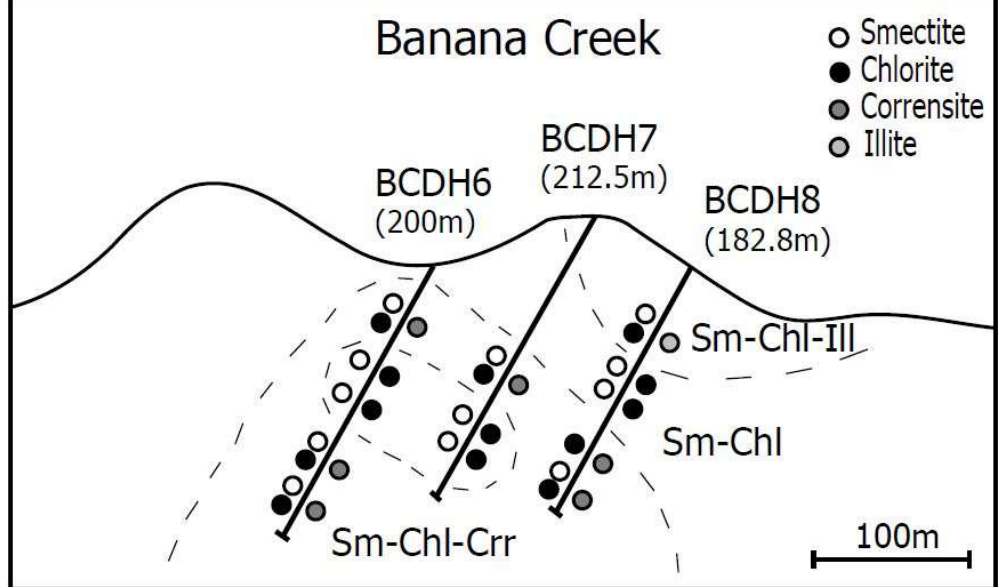
Figure 11. Cross-section through the Banana Creek prospect showing drill holes BCDH6, BCDH7, and BCDH8 and the down-hole distribution of alteration minerals: smectite, illite, corrensite, and chlorite. The length of the drill holes is also indicated.